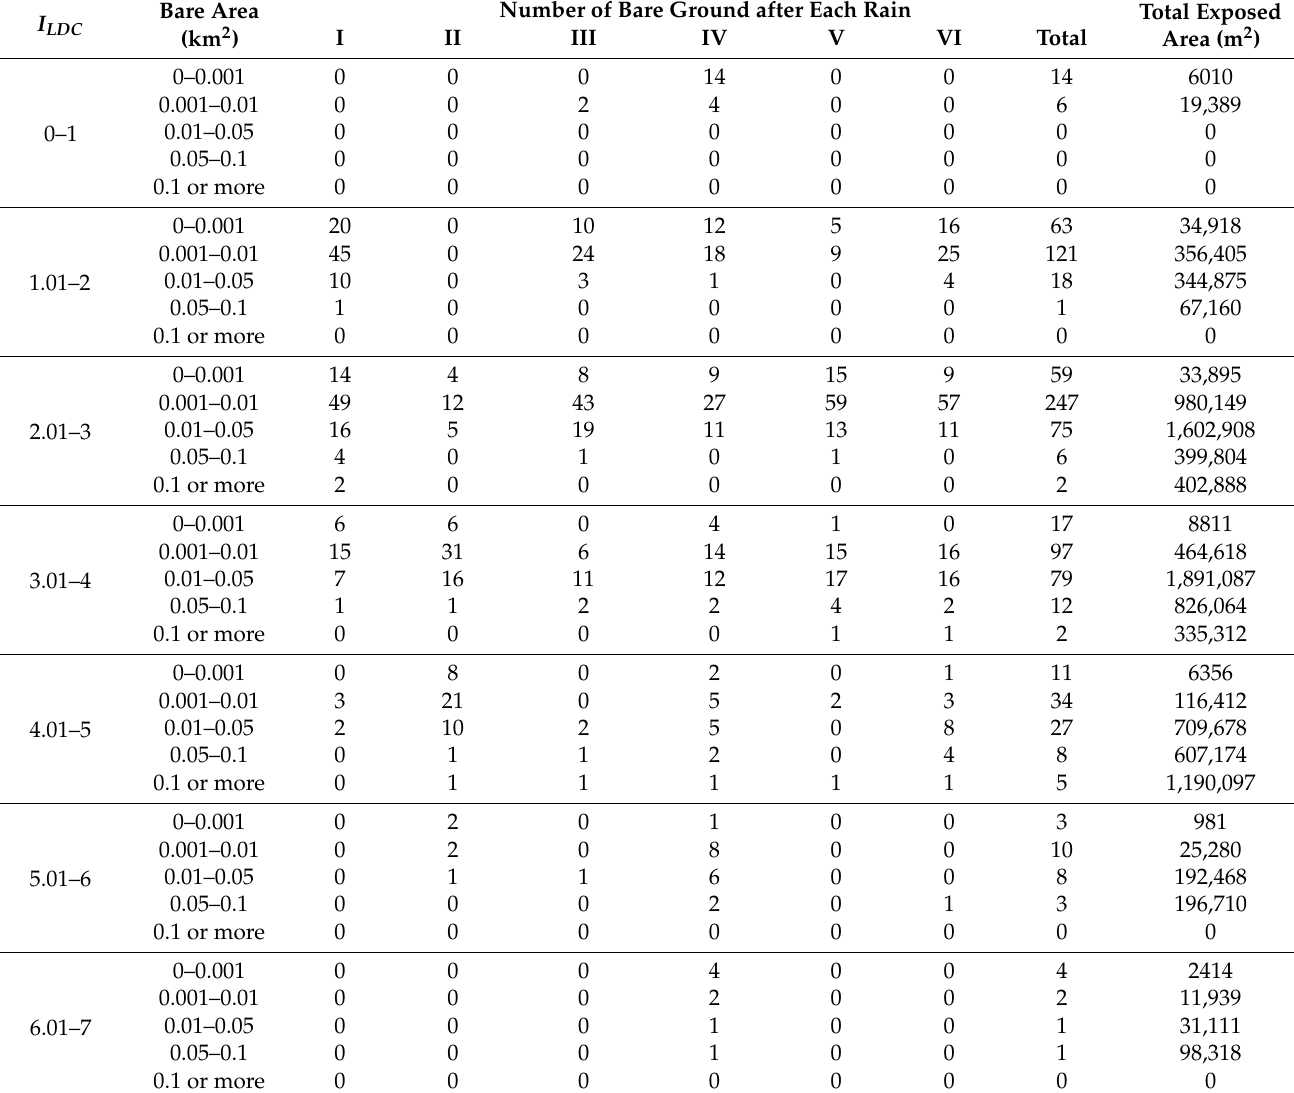
Table 9. Slope disturbance in the study area and the area and number of bare lands after each